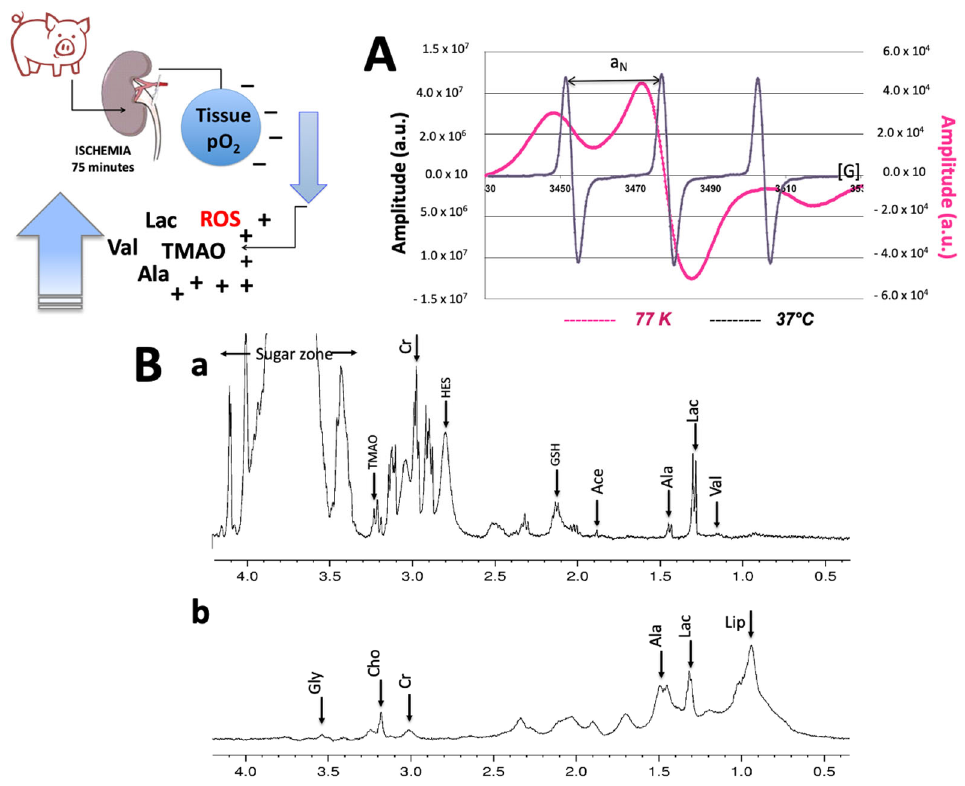
Figure 9. ( A ) EPR spectra recorded from both frozen kidney tissue (77 K) and from perfusion solution at 37 °C. The signals come from the reaction of 1-hydroxy-3-carboxymethyl-2,2,5,5-tetramethyl-pyrrolidine spin probe (CMH, EPR silent) to 3-carboxymethyl-2,2,5,5-tetramethyl-pyrrolidinyloxy radical (CM _ , EPR active). ( B ) High-field 1 HNMR spectra of ( a ) perfusate from a machine perfused in Belzer group at the end of the perfusion time (8 h, T2); ( b ) same expansion from a kidney biopsy at the same time. The correspondent metabolites are indicated by arrows.